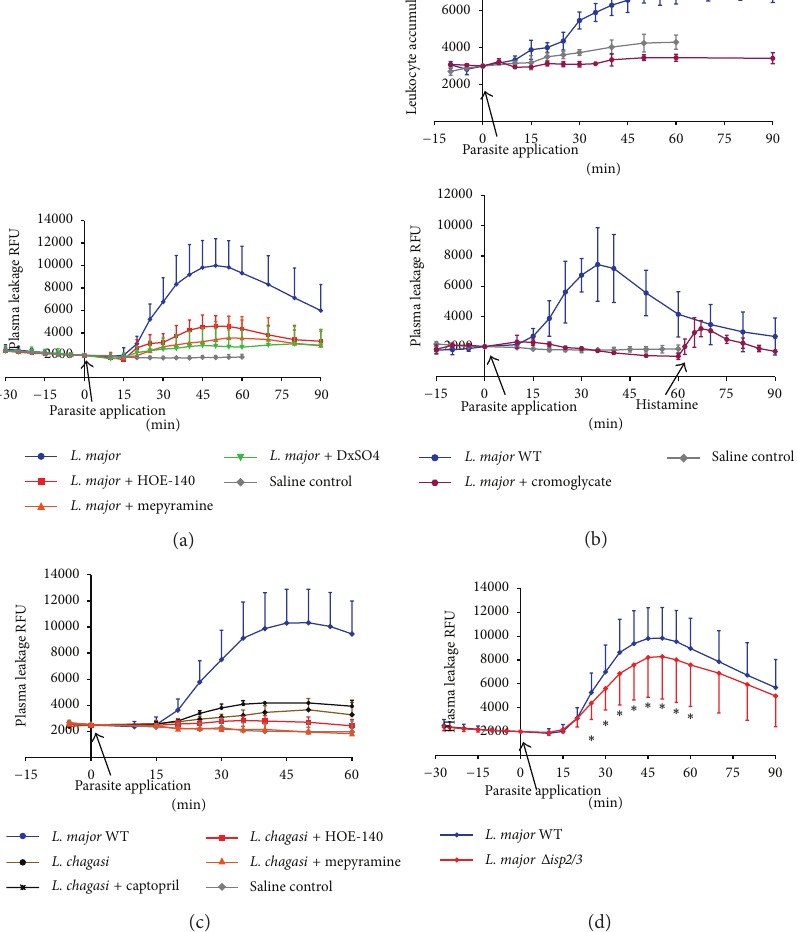
Figure 1: Microvascular plasma leakage and leukocyte accumulation in the HCP sensitized with Leishmania . The data represent relative fluorescence units (RFU: mean ± SD) induced by the topical application of L. major promastigotes (MHOM/JL/80/Friedlin, 500 𝜇 L of 1,5 × 10 7 /mL) on hamster cheek pouch preparations (HCPs) after 30 min of stabilization period without significant increase in RFU. Applications of promastigotes were made during 10min of interrupted superfusion of the HCPs. (a) Pharmacological interventions. Four groups of HCP were sensitized with L. major WT promastigotes, whereas one group (saline control; 𝑛 = 6 ) served as untreated control. The first group ( 𝑛 = 15